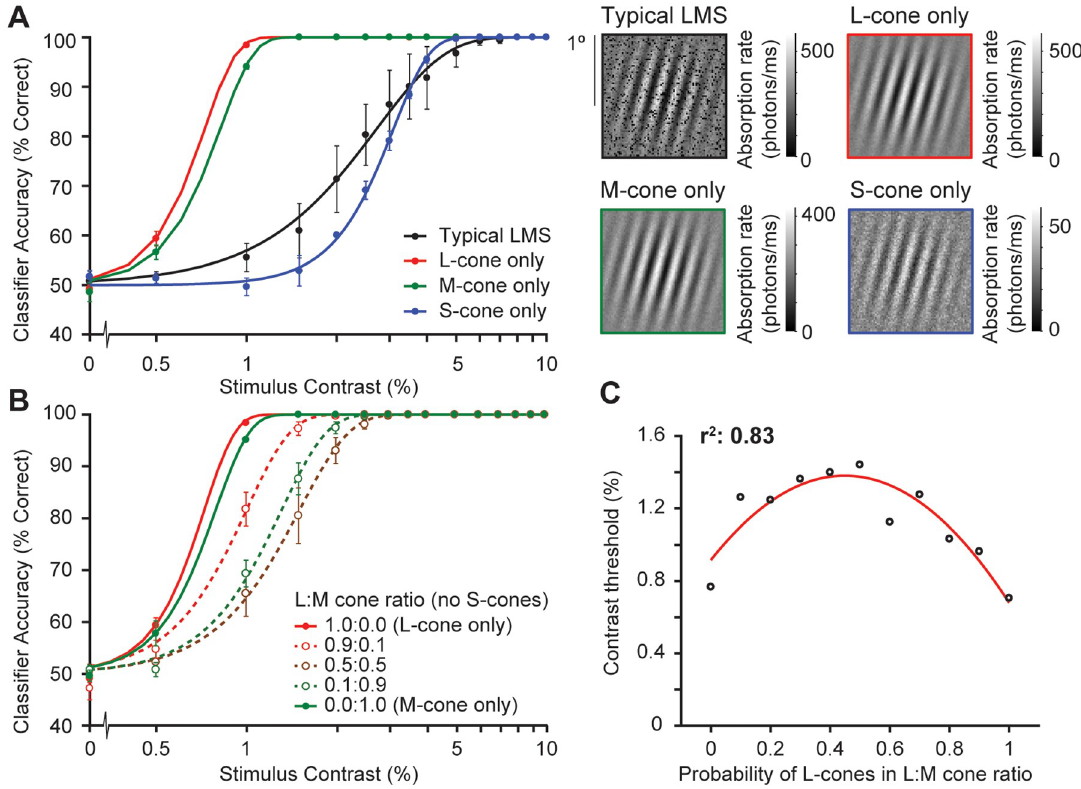
Fig 7. The effect of cone type on model performance. (A) Classifier accuracy for absorption rates as a function of stimulus contrast for the 4 different cone mosaics. Example isomerization images simulated by our computational observer model are shown on the right. A typical LMS cone mosaic has 60% L-cones, 30% M-cones, and 10% S-cones (black outline). L- and M-cone mosaics (red and green outline) have very similar absorption rates, whereas the absorption rate for S-cones is 4 times lower (blue outline). Each psychometric function is the average across performance of 2,000 trials per stimulus contrast (30,000 trials in total). Error bars represent standard error of the mean across 5 simulated experiments with 400 trials for each stimulus contrast. (B) Same layout as (A) but comparing simulated experiments with LM-only cone mosaics. We systematically varied the L:M ratio from L-cone only to M-cone only mosaics in steps of 10%. This panel shows L-cone only (solid red line) and M-cone only (solid green line); the same as in panel A. The three mixture mosaics contain 90% L-cone and 10% M-cone (dashed red line), 50% L- and M-cone (dashed brown line), and 10% L-cone and 90% M- cone (dashed green line). No S-cones were included in these mosaics. (C) Contrast thresholds as a function of probability of L-cones in all LM mixture cone mosaics, fitted with a quadratic